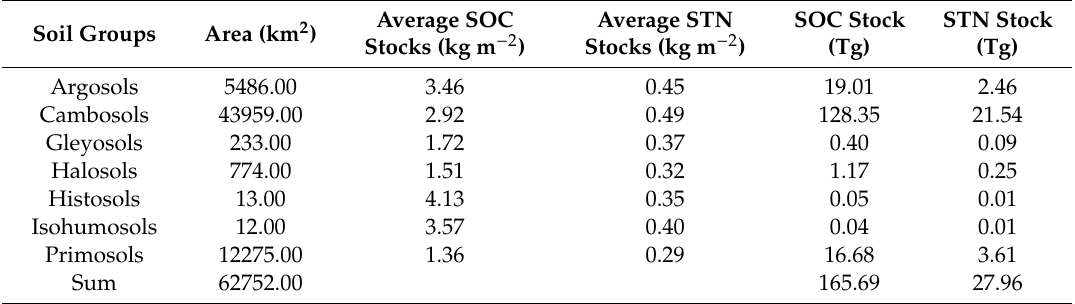
Table 5. Statistical description of soil organic carbon (SOC) and soil total nitrogen (STN) stocks of each soil groups according to the Chinese soil system classification estimated with boosted regression model (BRT) in forest topsoil (0–30